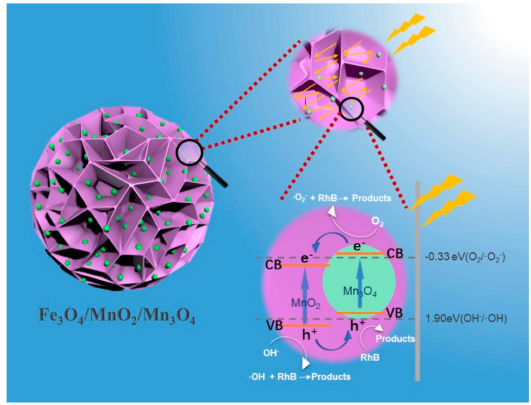
performance under visible